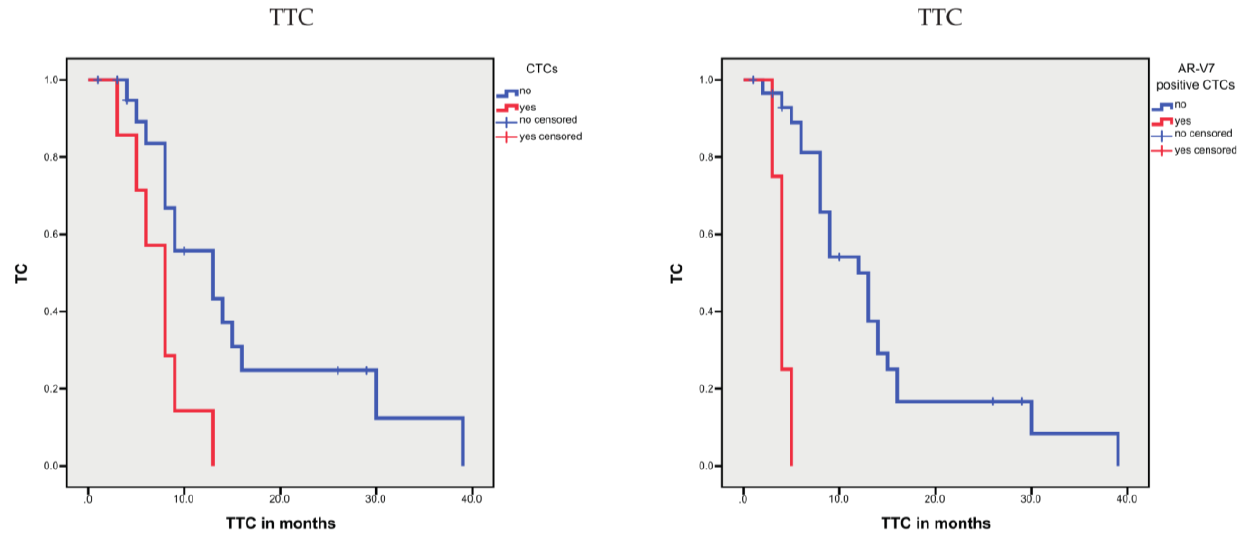
Figure 8. Kaplan–Meier analysis: association of CTCs or AR-V7-positive CTCs with time to treatment change (TTC). The presence of CTCs or AR-V7-positive CTCs was associated with a shorter TTC ( p = 0.031 or p < 0.001).